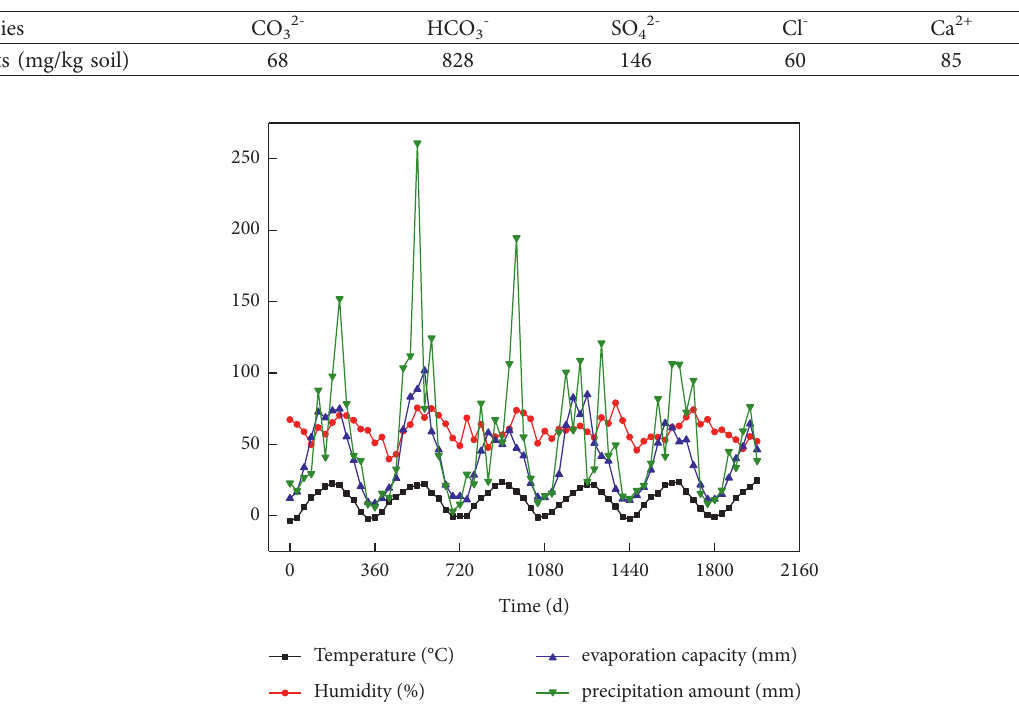
Figure 1: The climatic pattern of exposure points during the exposure